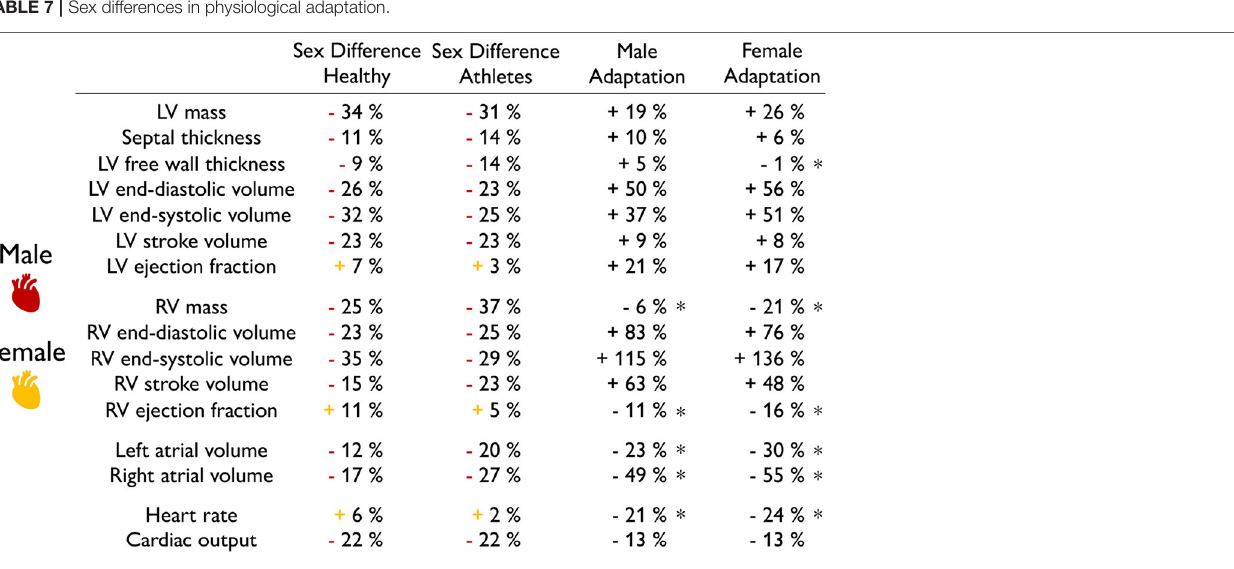
TABLE 7 | Sex differences in physiological